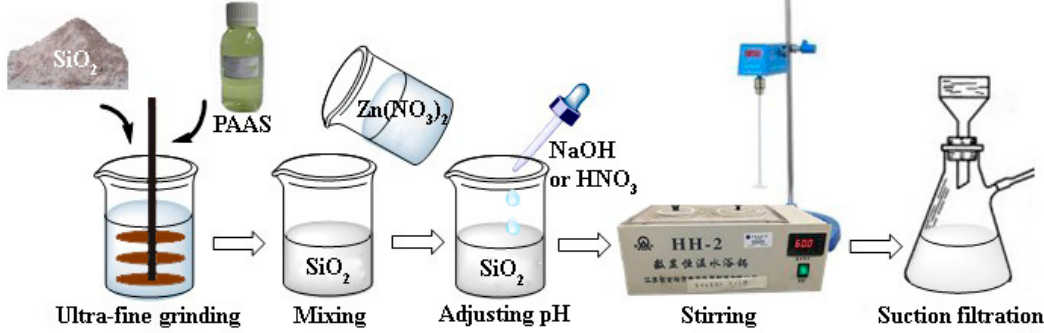
Figure 2. Preparation of composite particles of ZnO–SiO 2 precursor.